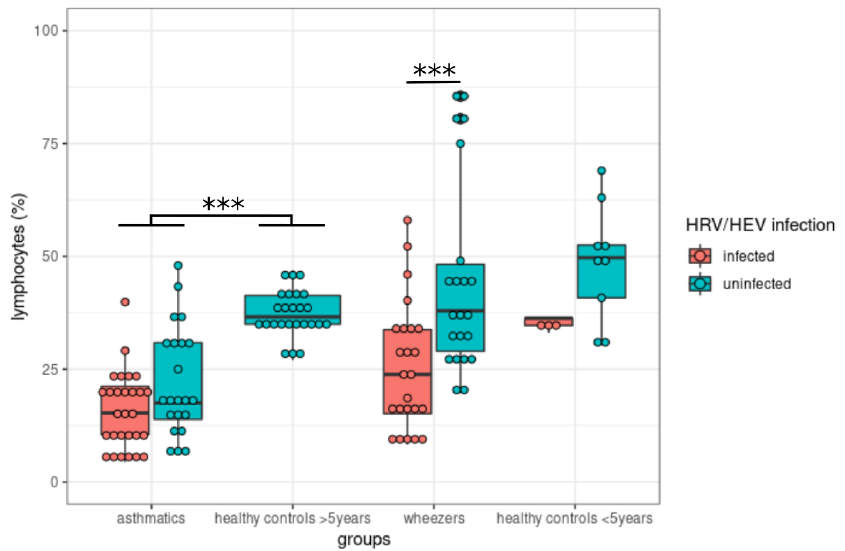
Figure 3. Lymphocytes decreased in HRV/HEV-infected subjects. Post-hoc pairwise comparisons of infected versus non-infected subjects were conducted within each group using the Mann–Whitney U, non-parametric test. *** = p < 0.001.